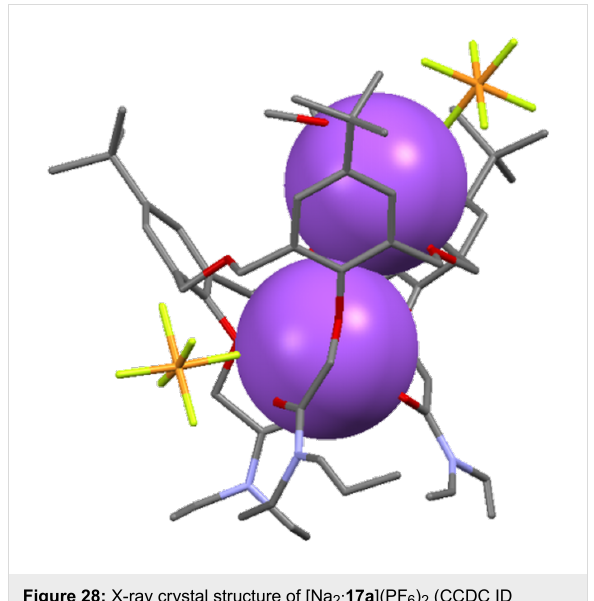
Figure 28: X-ray crystal structure of [Na 2 ∙ 17a ](PF 6 ) 2 (CCDC ID 116656)